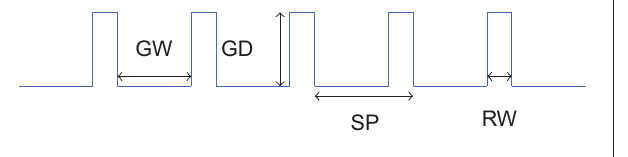
Table 3 | Set of sandpapers used for the experiment: geometrical properties.